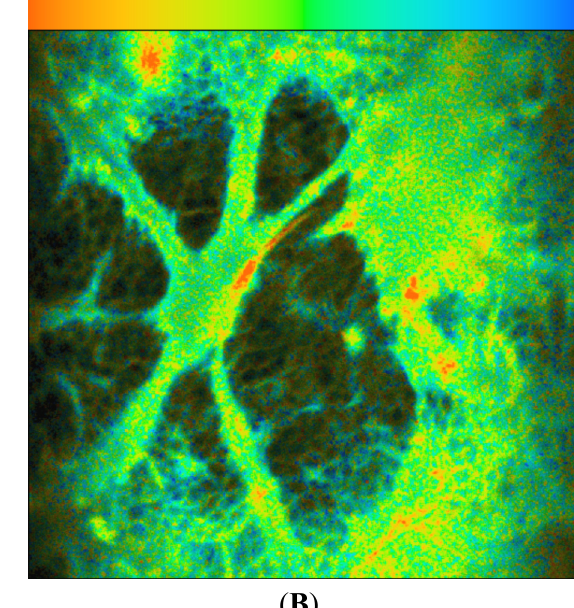
Figure 3. ( A ) Vivascope 658 nm reflectance image and ( B ) FLIM image acquired 20 µm below the skin surface 3 h after application of fluorescein in PBS at 16 mg/mL, magnification 400×; Field of view: 500 micron × 500 micron, FLIM color range 2–4 ns